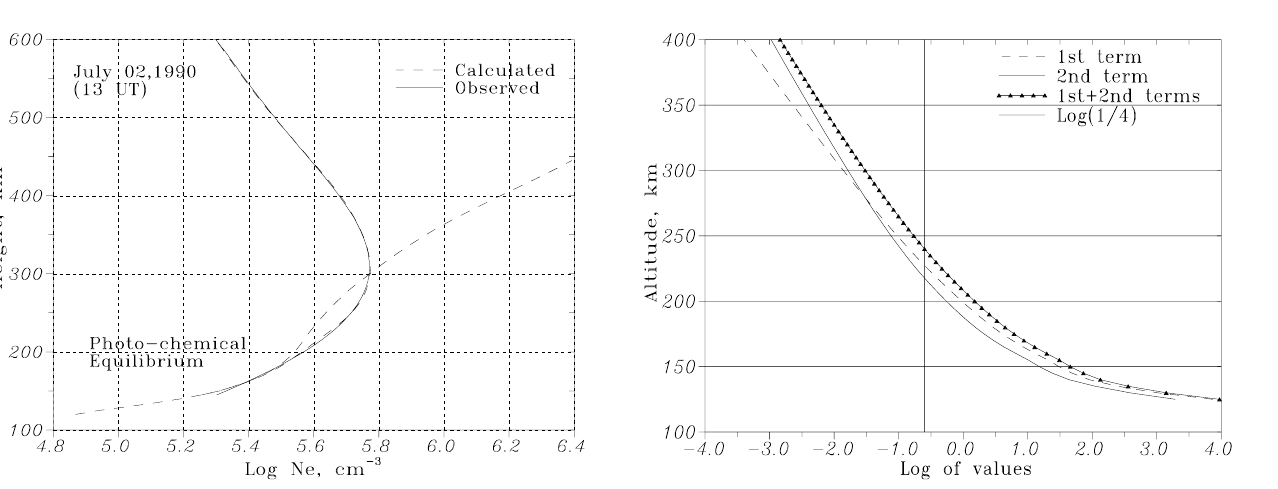
Fig. 7. Comparison of the two terms from the expression (3). Verti- cal line corresponding to log 10 ( 1 / 4 ) (see (4)) divides the ionosphere by the lower and the upper parts where molecular and atomic ions